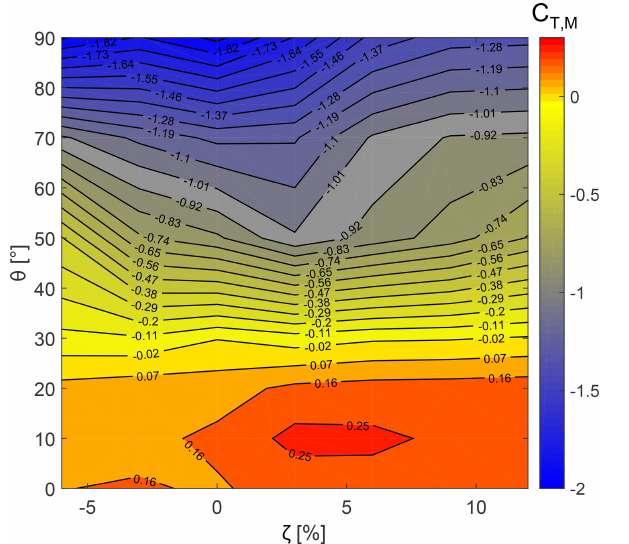
Figure 9. Effect of the variable radial gap and deflection angle of the flap on the duct thrust force coefficient using the RANS